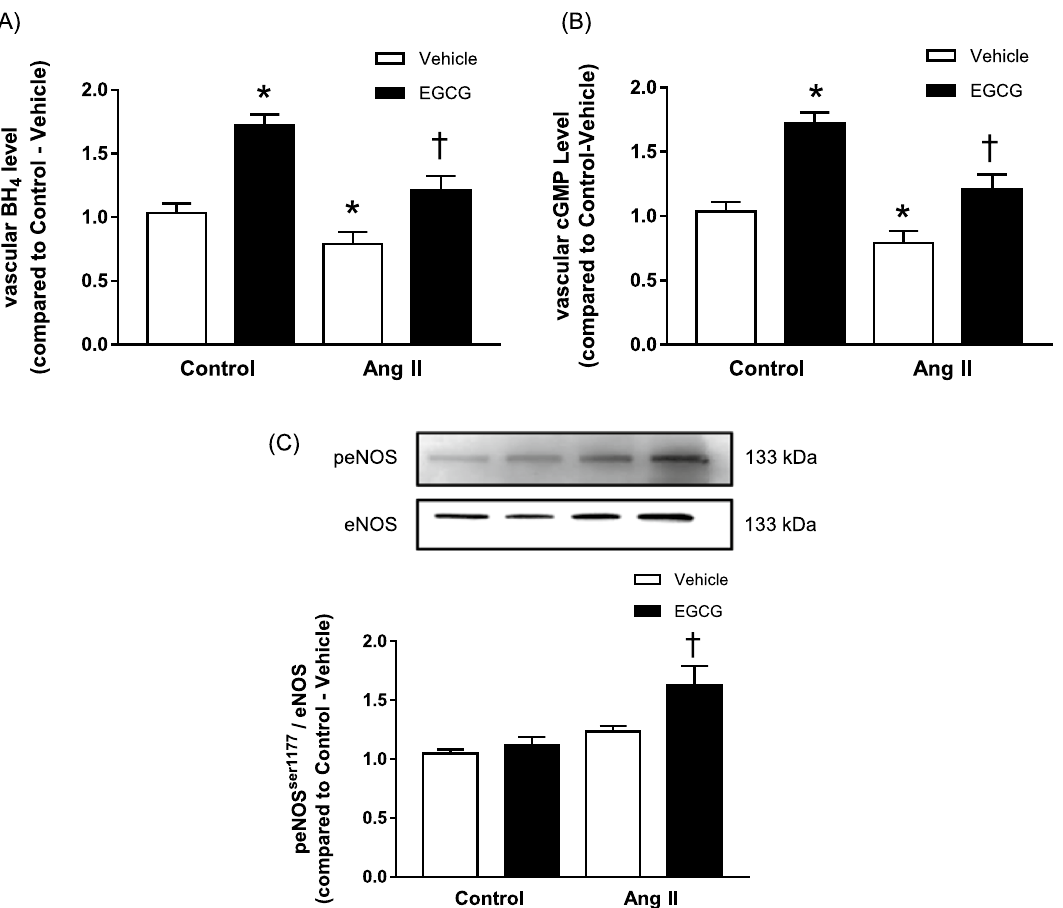
Figure 4. Vascular BH 4 ( A ) and vascular cGMP ( B ) levels measured using commercially available ELISA kits and the presence of total phosphorylated eNOS (p-eNOS) at ser 1177 ( C ) detected by Western blotting in the aortic tissues of control and angiotensin (Ang) II-infused hypertensive C57BL/6J mice, with and without in vivo treatment with epigallocatechin gallate (EGCG). The upper panel shows representative Western blots and the bottom panel shows the ratio of protein to eNOS ( C ). Data are expressed as means ± SEM (n = 5–6). *p ≤ 0.05 compared to control—vehicle; † p ≤ 0.05 compared to Ang